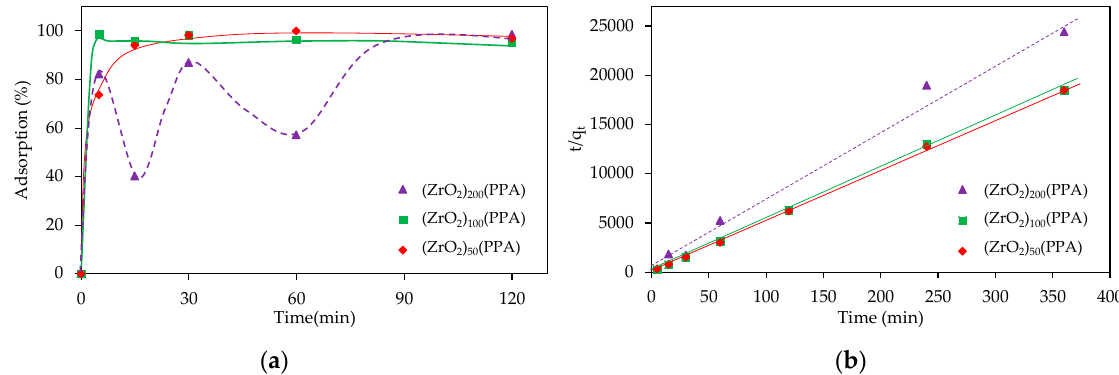
Figure A6. ( a ) Evolution with time of benz(a)anthracene adsorption using (ZrO 2 ) 100 (VPA) and (ZrO 2 ) 100 (PPA) and ( b ) Pseudo-second-order kinetic plots for the adsorption of benz(a)anthracene using (ZrO 2 ) 100 (VPA) and (ZrO 2 ) 100 (PPA).